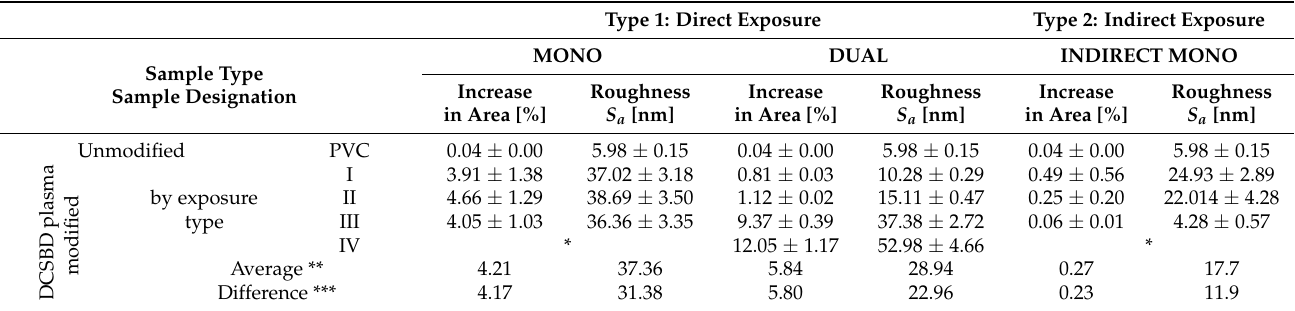
Figure 7 . Different topography of unmodified surfaces of PVC . The obtained results of the increased surface area and roughness for polymer films PVC modified by DCSBD plasma discharge realized for both sides (DUAL) in exposure types I, II, III and IV are shown in Table 2 and Figure 8. Table 2 . Comparison of surface area increase and change of roughness on PVC polymer film sur- faces after different types of modification using DCSBD plasma discharge.